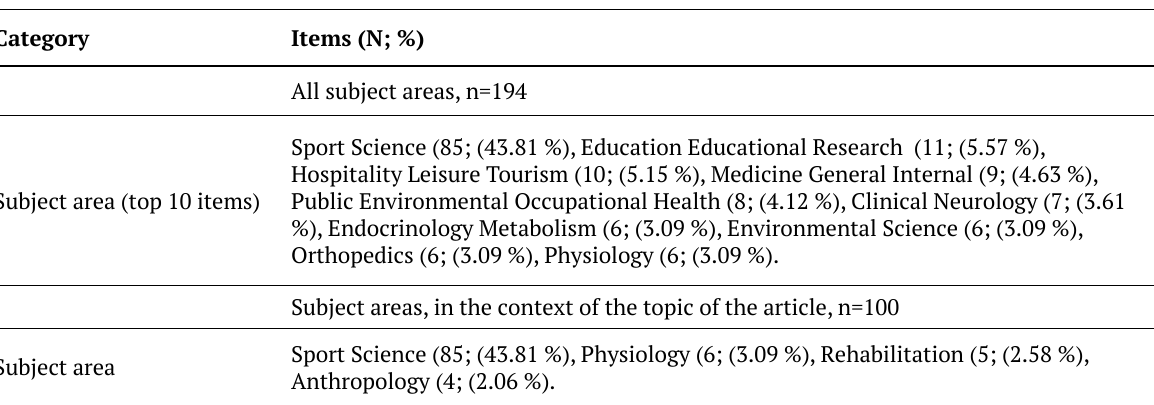
Table 1. Results analysis table for web of science categories field (Web of Science Core